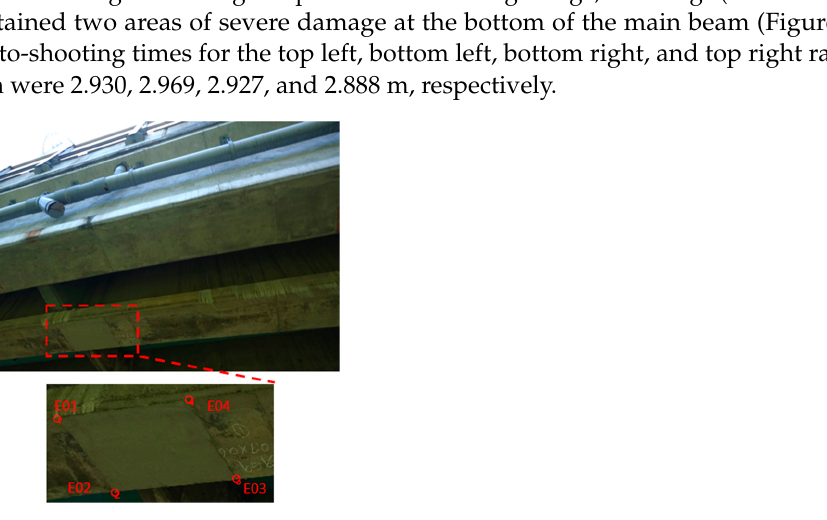
Figure 17. Damage at the bottom of the main beam at the test site: Refilled concrete.